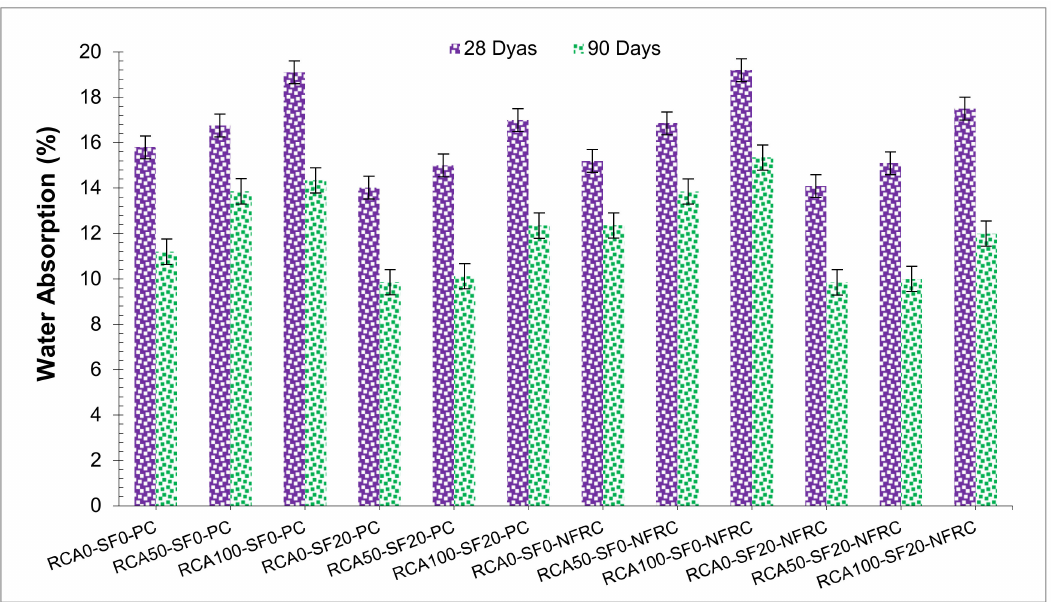
Figure 8. Water Absorption of